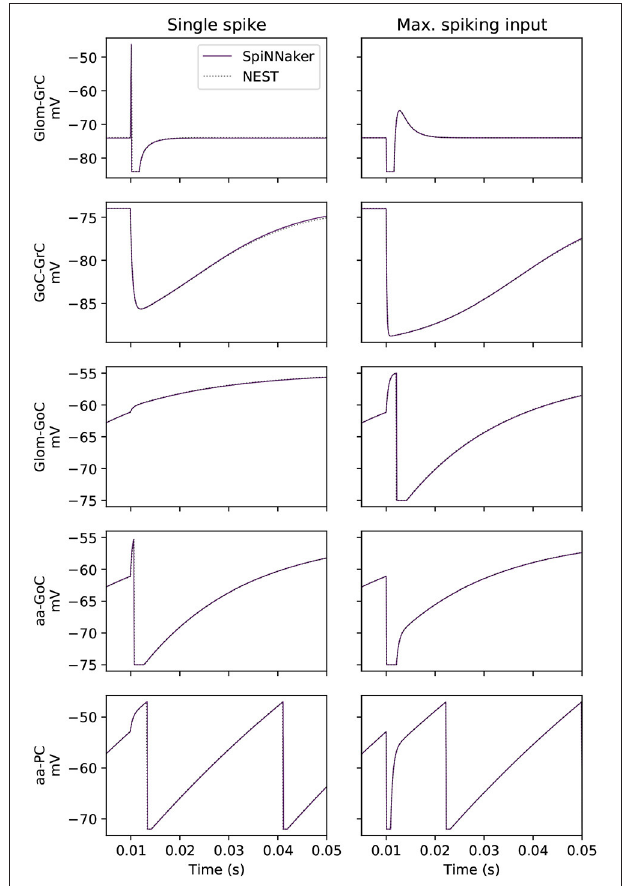
FIGURE 2 | Side-by-side membrane potential traces under two experimental conditions. The experiment tests each cell type under the influence of a single spike from each possible afferent projection, a subset of which is presented here. The effect of the single spike is also scaled by the empirically recorded maximum contribution of each individual projection to single post-synaptic neurons (labeled here as “max. spiking